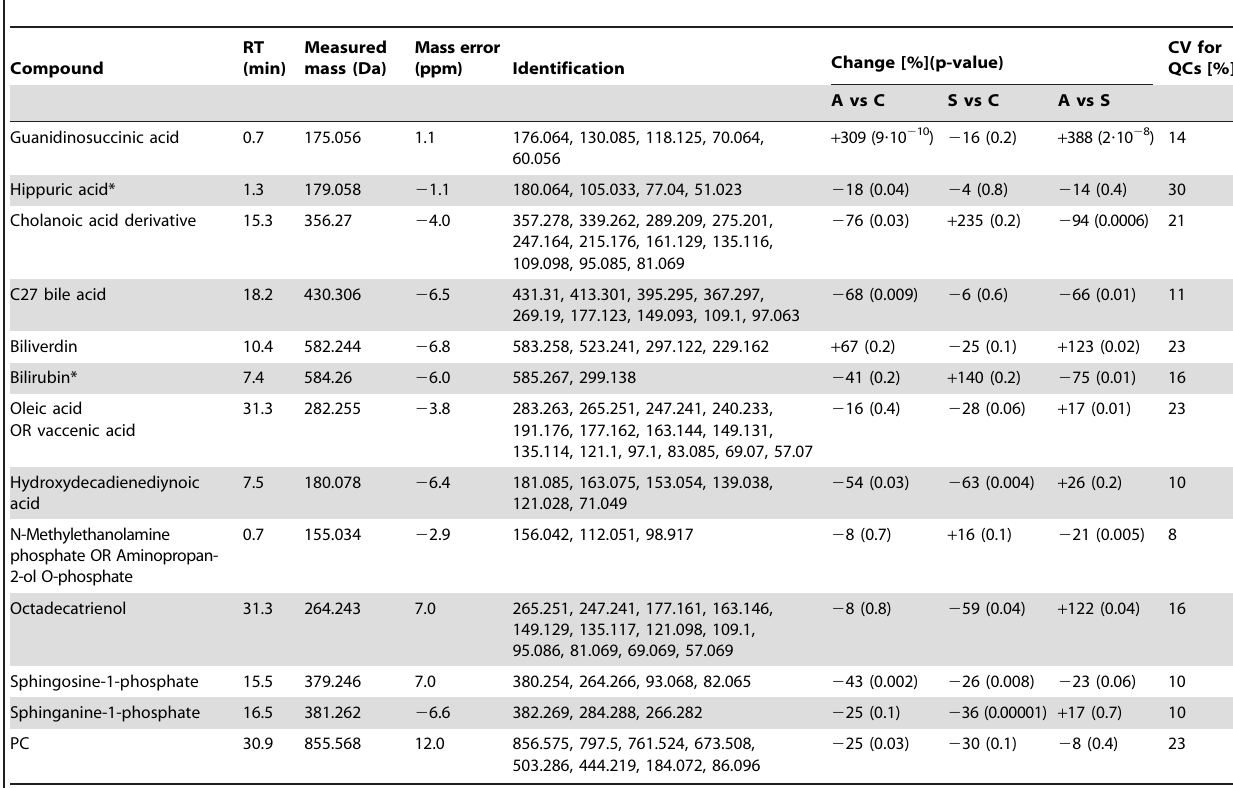
Table 2. Identification of metabolites that were significantly differentiating plasma profiles of AAA patients from controls.